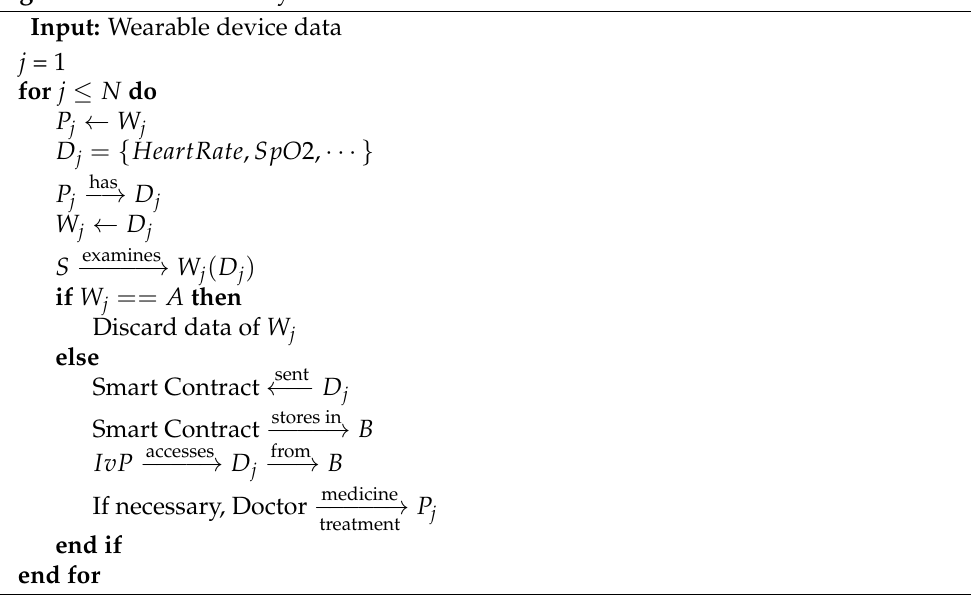
Algorithm 1 Flow of the